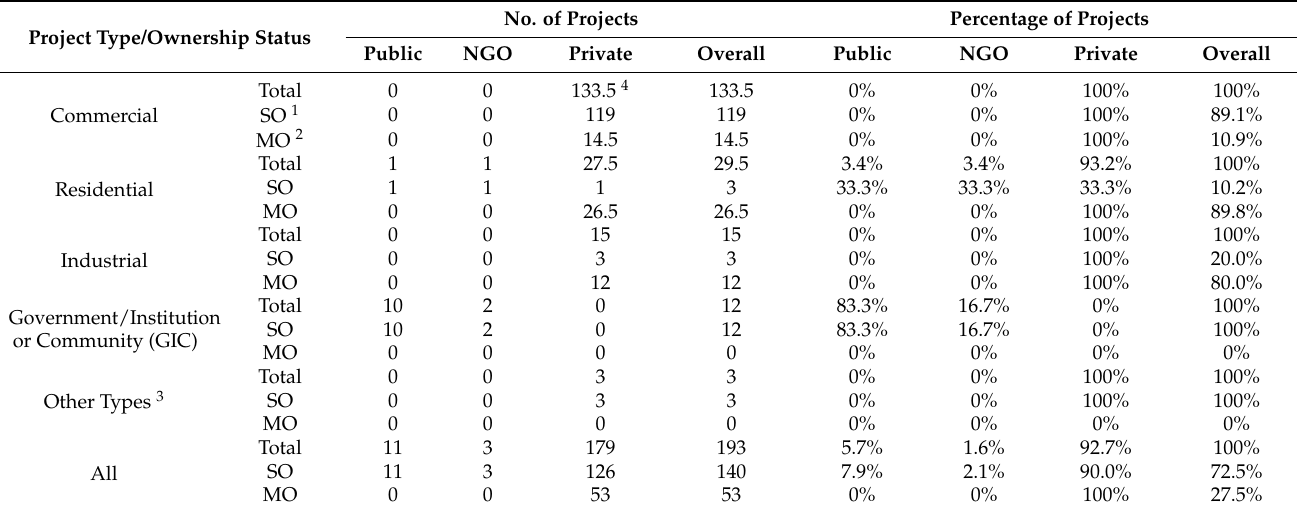
Table 3. Cross-table showing the breakdowns of certified projects by project types, ownership status, and owner types (N =